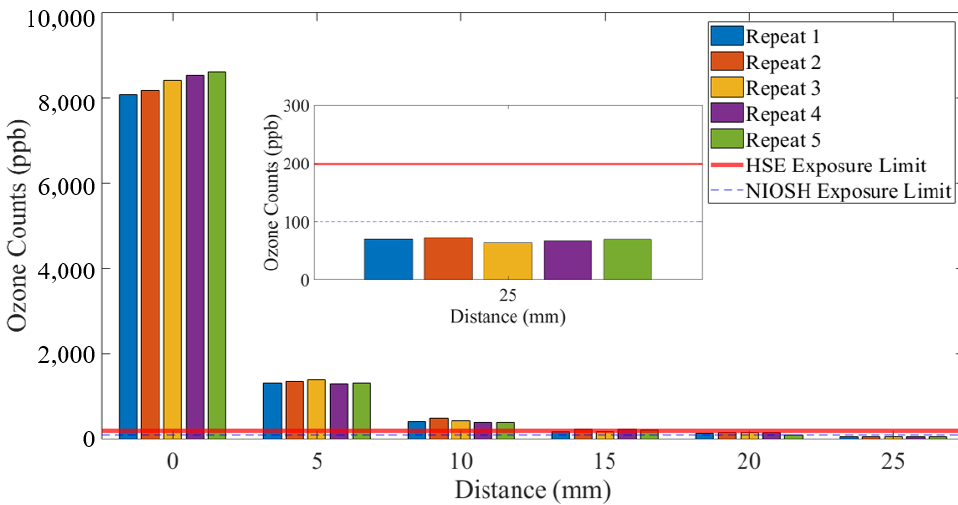
Figure 8. Ozone measurements: 80 L/min extraction system.